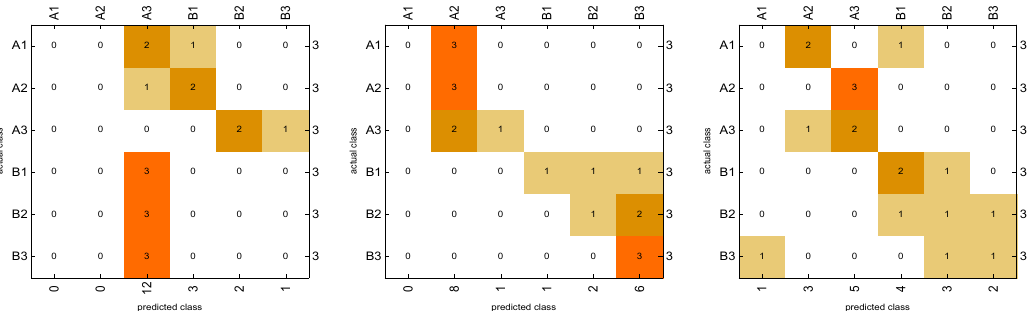
Figure 2. The confusion matrices for the results of classification based on RF ( left ), SVM ( center ), and ANN ( right ).